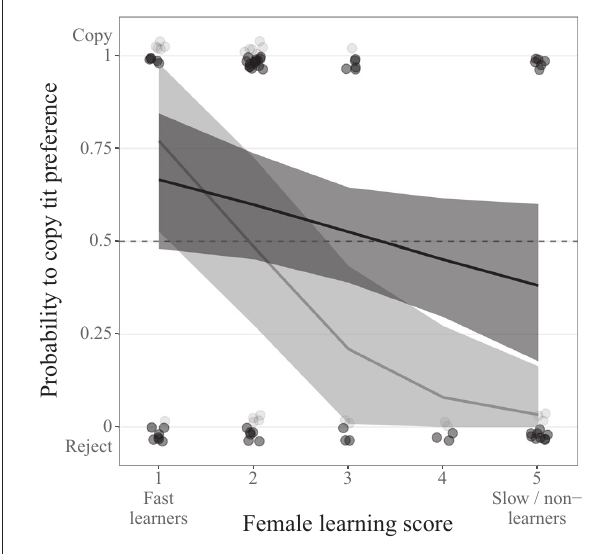
FIGURE 4 | Relation between learning score (from 1 to 5) and the probability to copy apparent tit preference for nest site choice in flycatcher females, depending on female age (light gray: yearlings: N = 25, dark gray: older females: N = 59). Predicted distributions (mean and 95% CI) are estimated from the model including the interaction between learning score and age, with a mean value set for other continuous predictors (see Supplementary Table 2 ). Data points show actual